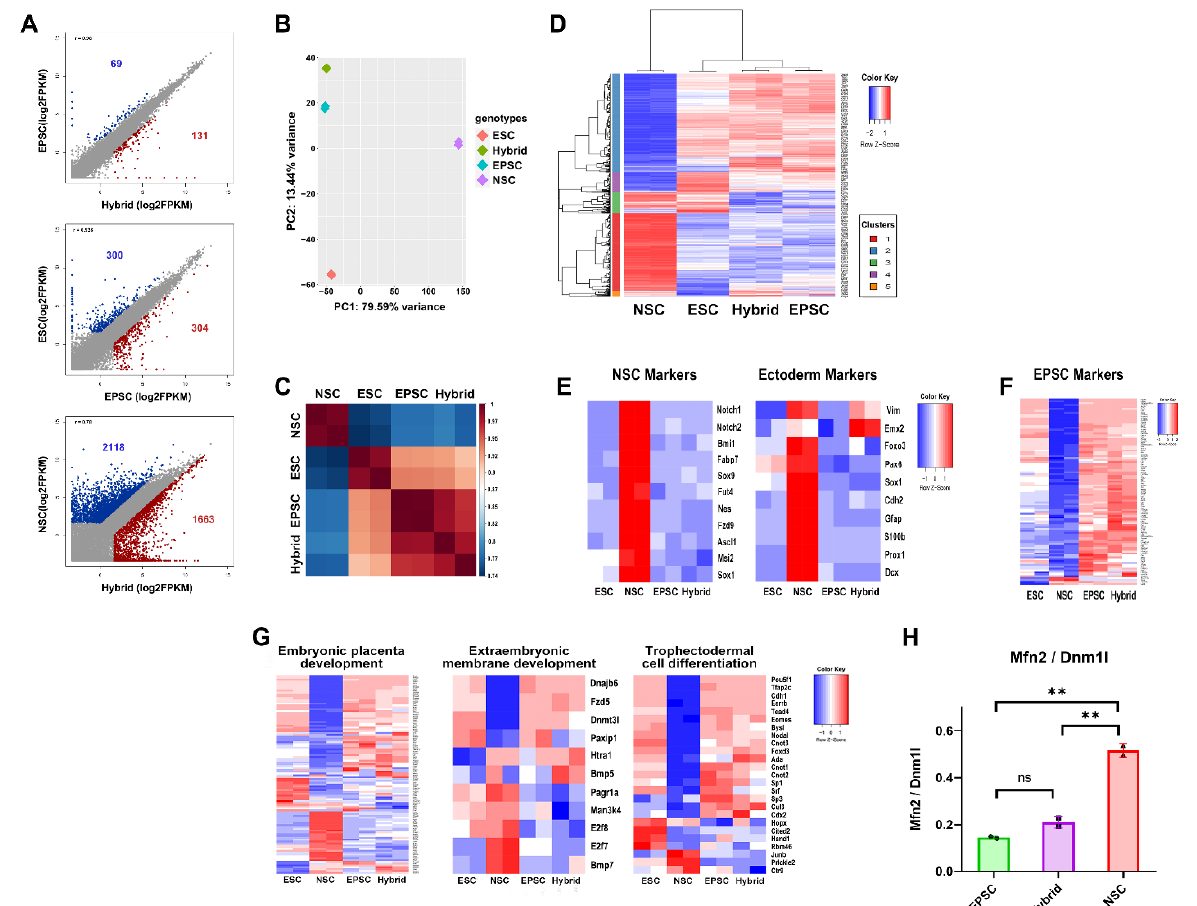
Figure 4. RNA sequencing analysis of ESCs, EPSCs, NSCs, and EPSC-NSC hybrid cells. ( A ) Scatter plot analysis showing the pairwise comparisons between EPSCs and hybrid cells, ESCs and EPSCs, and NSCs and hybrid cells. ( B ) Two-dimensional PCA analysis of ESCs, EPSCs, NSCs, and EPSC-NSC hybrid cells. ( C ) Correlation matrix analysis of ESCs, EPSCs, NSCs, and EPSC-NSC hybrid cells. ( D ) Hierarchical heatmap cluster of DEGs among ESCs, EPSCs, NSCs, and EPSC-NSC hybrid cells. ( E ) Heatmap of expression of ectoderm (left) and NSC marker genes (right) in ESCs, EPSCs, NSCs, and EPSC-NSC hybrid cells. ( F ) Heatmap of expression of EPSC marker genes in ESCs, EPSCs, NSCs, and EPSC-NSC hybrid cells. ( G ) Heatmap of expression of genes related to placenta development in ESCs, EPSCs, NSCs, and EPSC-NSC hybrid cells. ( H ) Ratio of Mfn2/Dnm1l in EPSCs, NSCs, and EPSC-NSC hybrid cells. Data